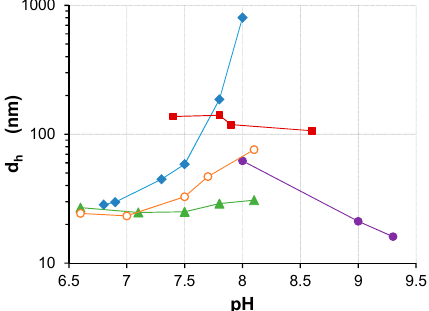
Figure 6. The mean hydrodynamic diameter ( d h , nm) of stable S-PE particles 72 h after particle growth initiation by addition of the appropriate volume of (0.1 M) HCL (see Experimental Section 2.2.3). Each data point is obtained using exponential fit of individual DLS data sets ( i.e. , d h vs. time curves) gathered at the corresponding pH: S-PDMAEMA 60 (blue diamonds ♦ ), S-PMOTAI (red squares ■ ), S-PDMAEMA 60 - b -POEGMA 38 (green triangles (cid:78) ), S-PMOTAI 60 - b -POEGMA 38 (purple circles ‚ ) and PDMAEMA 300 (orange circles ˝ ). All S-PE composites were prepared using a 1:1 (10 mM) SS/DMAEMA or SS/MOTAI ratio with respect to the concentration of amine-functional repeating